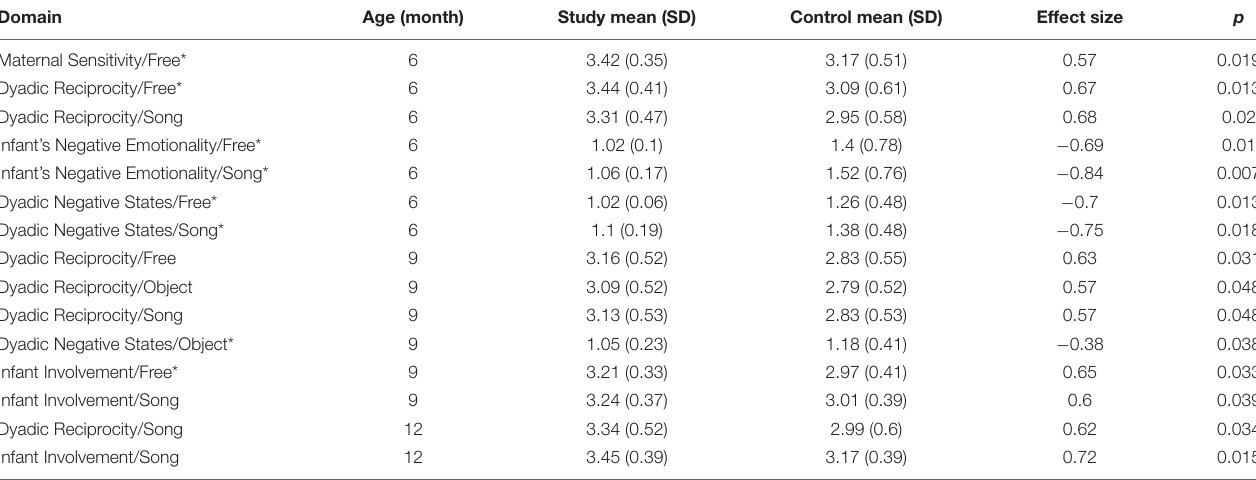
TABLE 2 | Significant differences between study and control groups for the investigated domains.